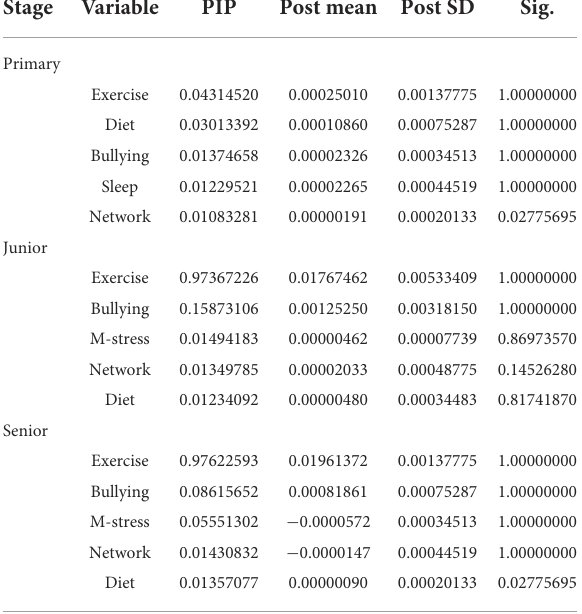
TABLE 3 BMA estimation results of explanatory variables for each grade.